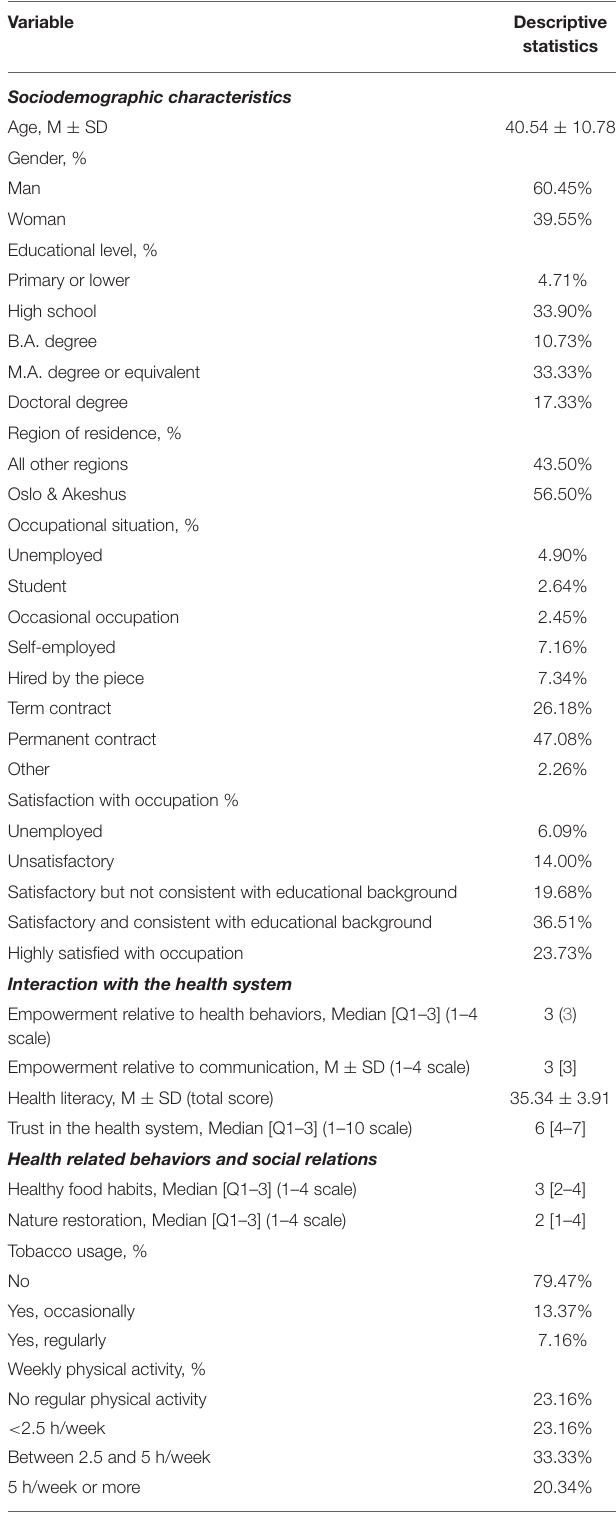
TABLE 2 | Descriptive statistics of Self-rated health, perceived impact of moving, and other information about the health and living conditions of Italian immigrants in Norway (oversampled dataset, n =